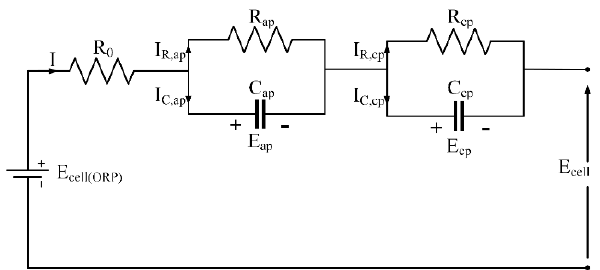
Figure 49. Equivalent electrical circuit of a unit cell, laboratory unit V-RFB system, which is very similar to Li-ion and Ni-MH batteries [149].